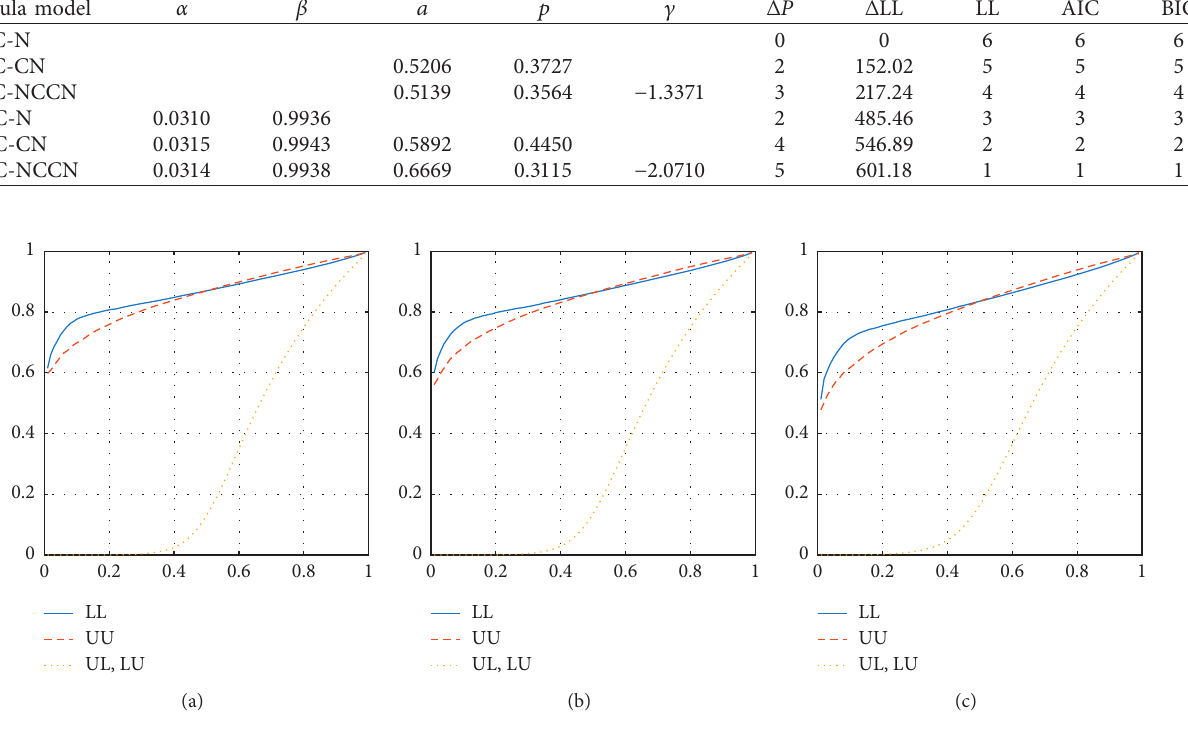
Figure 18: QD curves of multivariate CCC-NCCN copula model. (a) HSI-CEI. (b) HSI-CCI. (c) CEI-CCI.